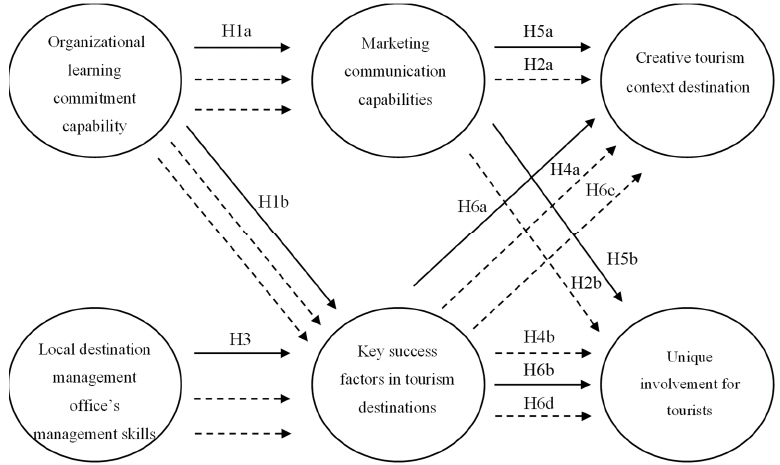
Figure 1. Conceptual model. Note : Dashed lines represent indirect relationships.